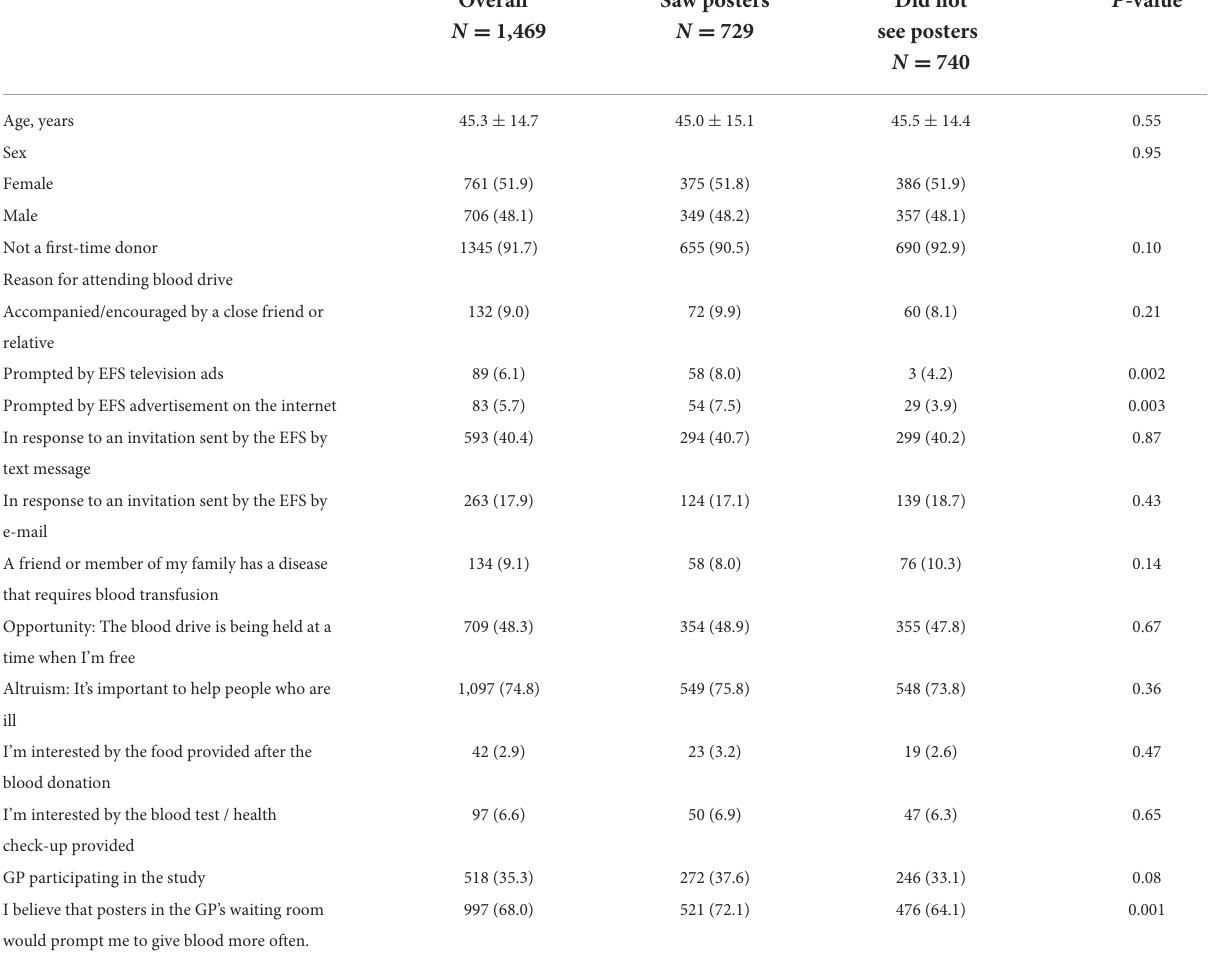
TABLE 4 Univariate comparison of the characteristics of patients who saw the posters advertising the blood drive in a GP’s waiting room, vs. those who did not.